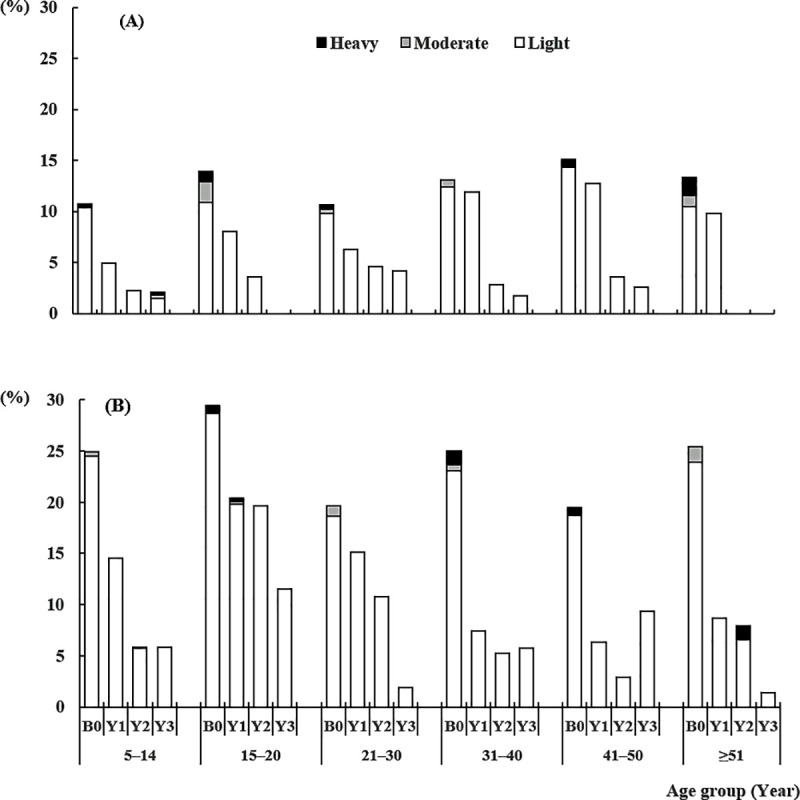
Hookworm infection intensity stratified by age group in sentinel areas of an MDA program to eliminate LF and onchocerciasis in eastern Côte d’Ivoire.(A), Akoupé health District with semi-annual MDA. (B), Abengourou health District with annual MDA. The last re-examination was performed 12 months after the last round of MDA. B0: Baseline, Y1: Year 1, Y2: Year 2, Y3: Year 3.